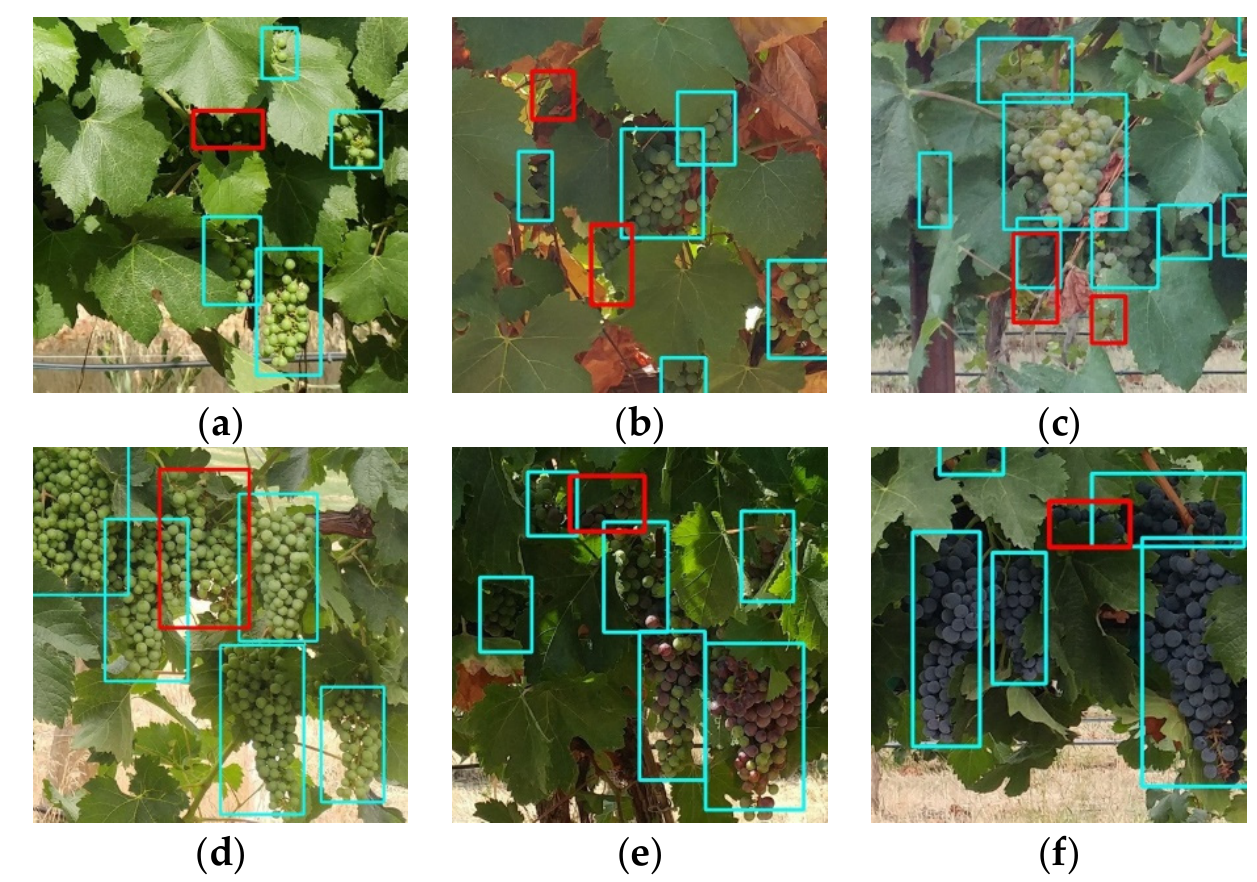
Figure 10. Illustrations of failures (i.e., true negatives (TN) or false positives (FP) highlighted in red bounding boxes; true positives (TP) in cyan bounding boxes) in grape bunch detection using Swin-transformer-YOLOv5 (Swin-T-YOLOv5) during early (left column), mid- (middle column), and harvest-stage (right column) for ( a – c ) “Chardonnay (white variety)” and ( d – f ) “Merlot (red variety)” in zoomed-in